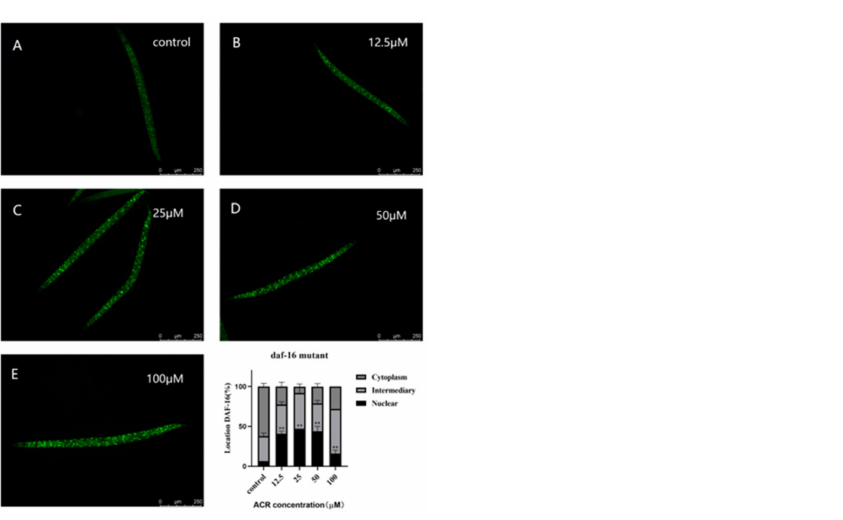
Figure 7. Effect of TJ356 stain exposed to four concentrations (12.5, 25, 50, and 100 µ M) of ACR on subcellular DAF-16 nuclear localization ( n ≥ 30 worms per group). Cytoplasm: The green fluorescence was diffusely distributed in the cytoplasm ( A ). Nuclear: The green fluorescence was concentrated in the nucleus and presented granularity ( C – E ). Intermediary: The green fluorescence was between the two states ( B ). ** compared with the control group, p < 0.01.